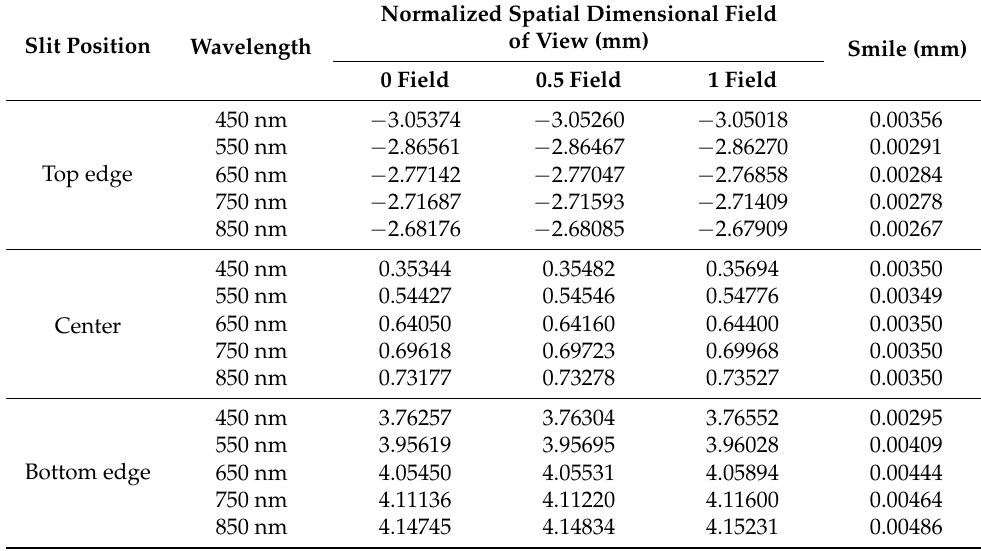
Table 1. Smile of optical